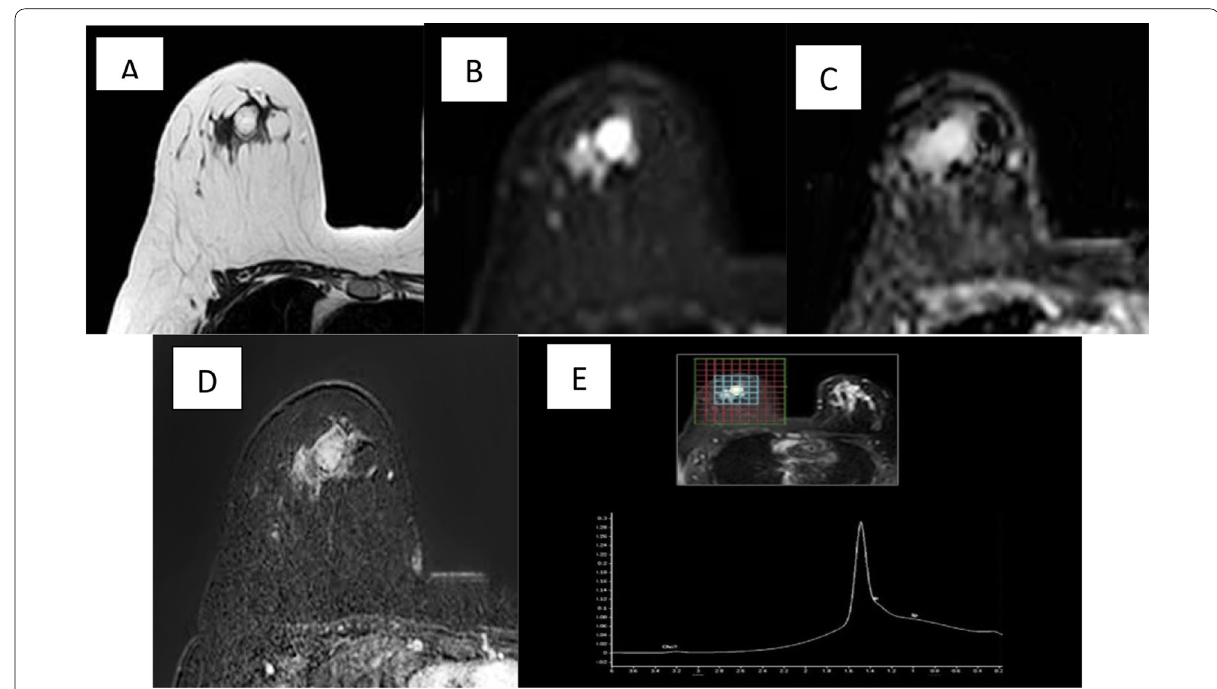
Fig. 3 A 37-year-old female with a right breast fibroadenoma. A Axial T2-WI, showing a well-circumscribed lesion of high signal with dark internal septations. B Axial DWI (b 1000), the lesion showed high signal. C Axial ADC map, the ADC value of the lesion was 1.25